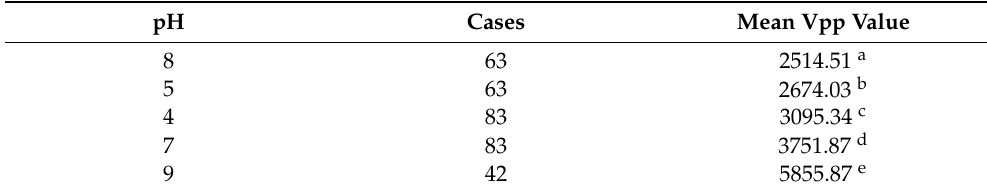
Table 18. Duncan’s Multiple Range Test for pH of Two-Way ANOVA results for the delay with selected